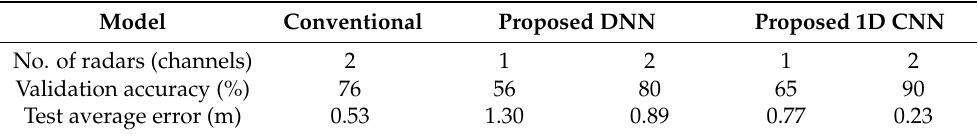
Table 2. Comparison of validation accuracy and average localization errors.